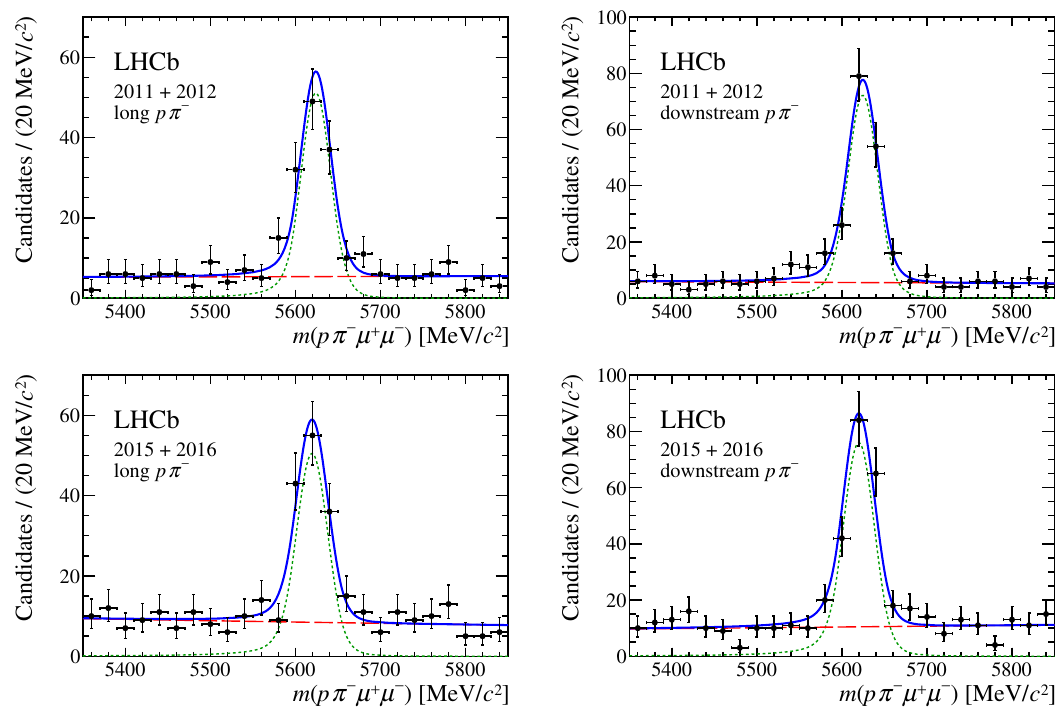
Figure 1 . Distribution of p(cid:25) (cid:0) (cid:22) + (cid:22) (cid:0) invariant mass for (left) long- and (right) downstream-track p(cid:25) (cid:0) categories in the (top) Run 1 data and (bottom) Run 2 data. The result of the (cid:12)t to each sample of data is indicated by the solid blue line. The signal and background components are illustrated by the dotted green and dashed red lines,